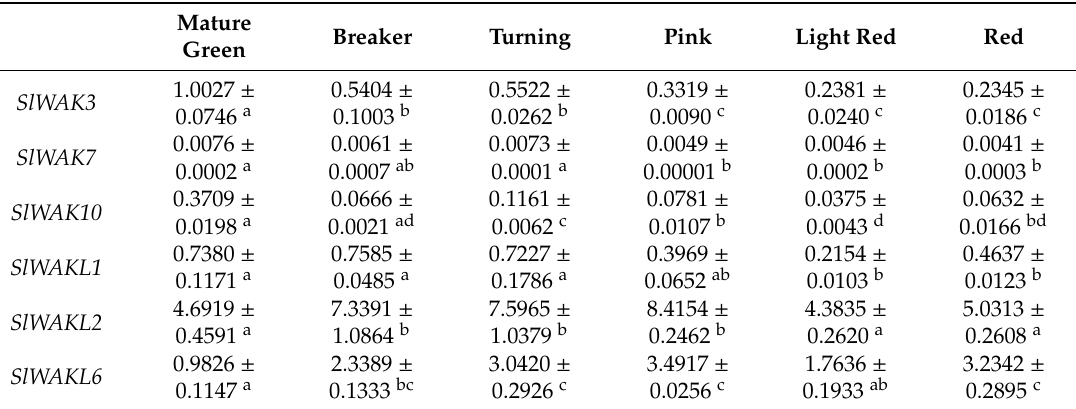
Table 3. Relative expression analysis of 6 selected SlWAK-RLKs in fruits. Mature Breaker Turning Pink Light Green